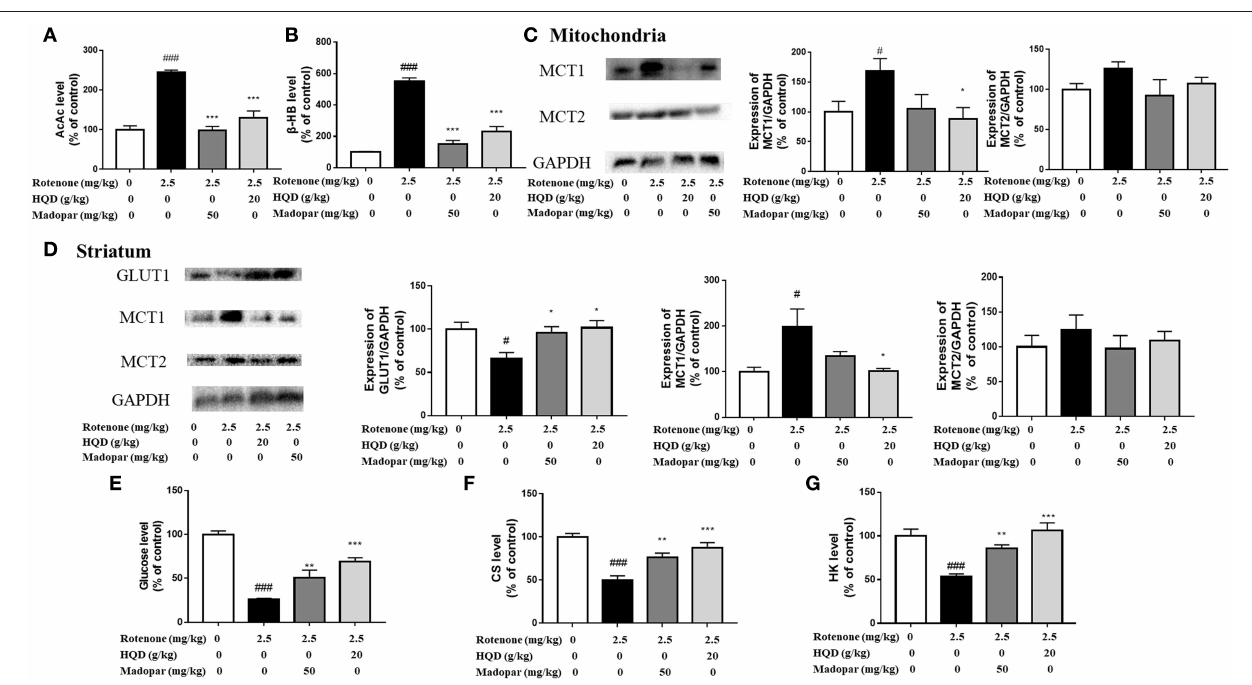
FIGURE 10 | Effect of HQD on aerobic glycolysis pathway and ketone body pathway. (A) The effect of HQD on AcAc level in midbrain mitochondria of rats with PD ( n = 6). (B) The effect of HQD on β -HB level in midbrain mitochondria of rats with PD ( n = 6). (C) The expression levels of MCT1 and MCT2 in midbrain mitochondria of rats with PD ( n = 4). (D) The expression levels of GLUT1, MCT1, and MCT2 in striatum of rats with PD ( n = 4). (E) The effect of HQD on glucose level in striatum of rats with PD ( n = 6). (F) The effect of HQD on CS level in midbrain mitochondria of rats with PD ( n = 6). (G) The effect of HQD on HK level in striatum of rats with PD ( n = 6). # P < 0.05, ### P < 0.001 vs. control group; ∗ P < 0.05, ∗∗ P < 0.01, ∗∗∗ P < 0.001 vs. rotenone